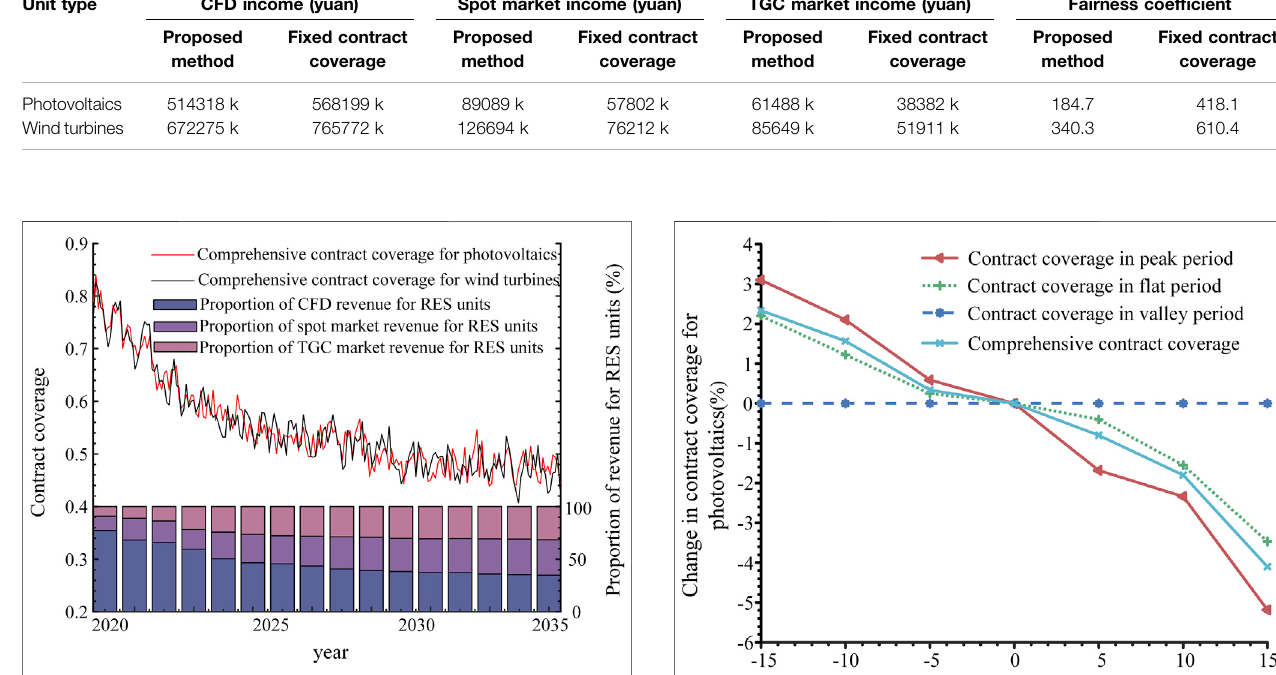
FIGURE 5 | Changes in contract coverage and revenue share of RES generation units from 2020 to 2035.